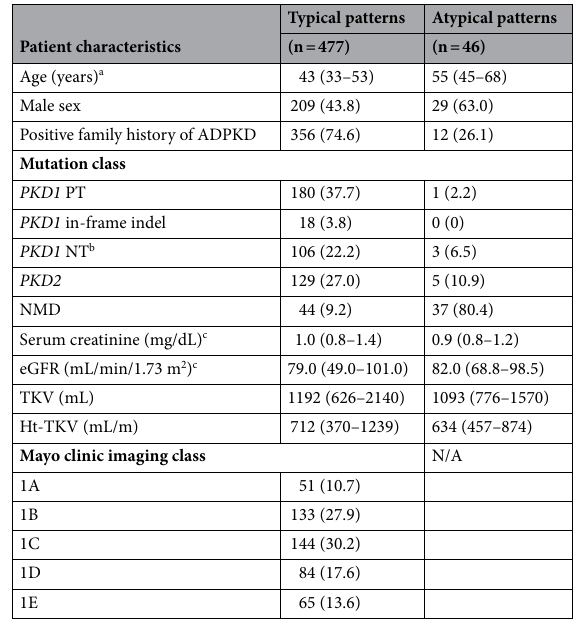
Table 2. Characteristics of the study cohort. Data expressed as number (%) or median (interquartile range). eGFR, estimated glomerular filtration rate; Ht-TKV, height-adjusted total kidney volume; NMD, no mutation detected; NT, non-truncating; PT, protein-truncating; TKV, total kidney volume. a At MRI/CT scan. b One patient who had both a PKD1 NT and a PKD2 mutation is included here. c At last